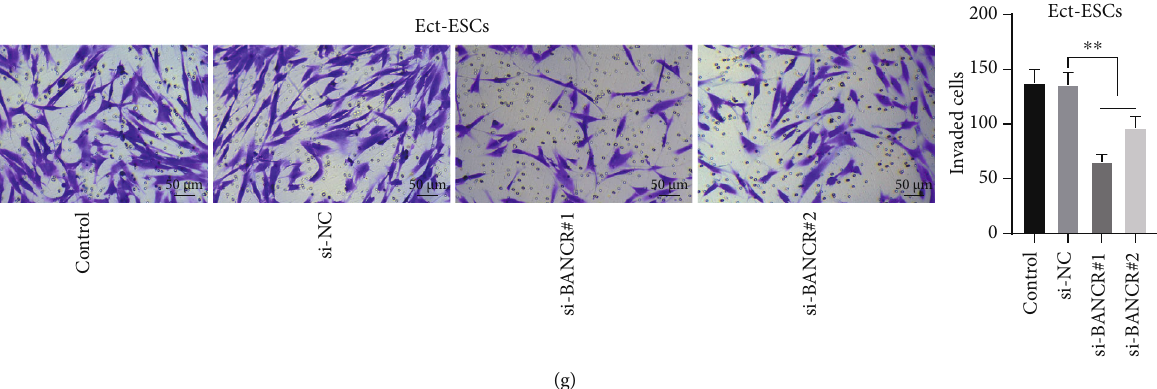
Figure 1: Silencing lncRNA BANCR suppresses ectopic endometrial stromal cell proliferation and invasion. (a) LncRNA BANCR expressions in eutopic and ectopic endometrial tissues ( N = 20 ) were determined by RT-qPCR; (b) CK19 and vimentin expressions were determined by immunocytochemistry; (c) LncRNA BANCR expressions in eutopic and ectopic endometrial stromal cells (Eut-ESCs/Ect-ESCs) were determined by RT-qPCR. Ect-ESCs were transfected with si- BANCR (si-BANCR#1 and si-BANCR#2), with transfection of si-NC as the negative control. (d) Knockdown e ffi ciency of si-BANCR was determined by RT-qPCR; (e, f) Proliferation potential of Ect-ESCs was assessed by CCK-8 (e) and colony formation (f) assays; (g) Invasion potential of Ect-ESCs was assessed by transwell assay. Cell experiments were performed thrice independently. Data in fi gures (c)-(d) were formalized as mean ± SD. Data in fi gures (a) and (c) were analyzed using the t test, data in fi gures (d), (f), and (g) were analyzed using one-way ANOVA, and data in fi gure (e) were analyzed using two-way ANOVA, followed by Tukey ’ s multiple comparison test. ** P < 0 : 01